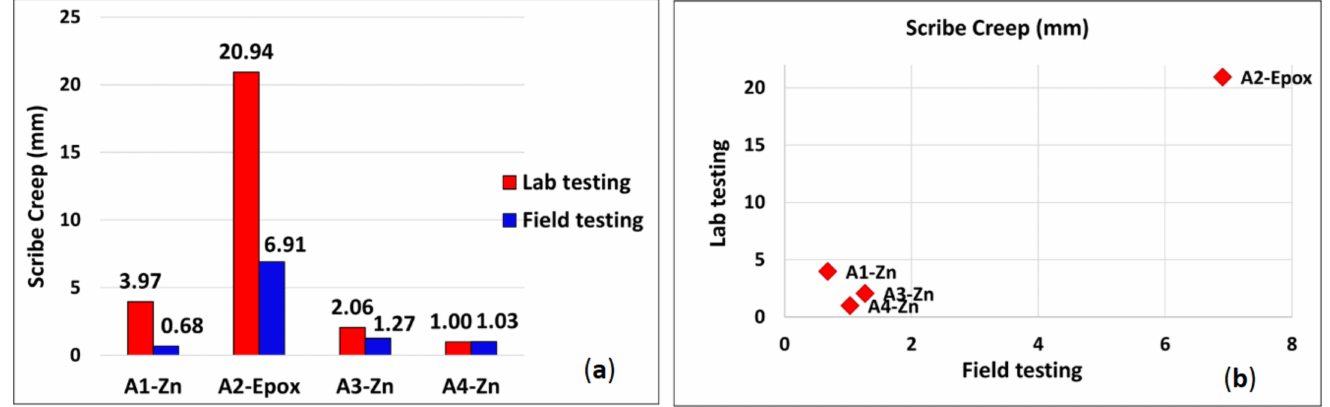
Figure 5. ( a ) Scribe creep of the atmospheric zone coating systems after accelerated aging and field testing. ( b ) Scribe creep after accelerated aging plotted as a function of scribe creep after field